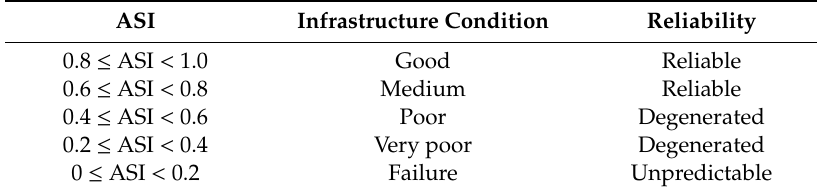
Table 3. Asset Condition from Asset Sustainability Index [45].